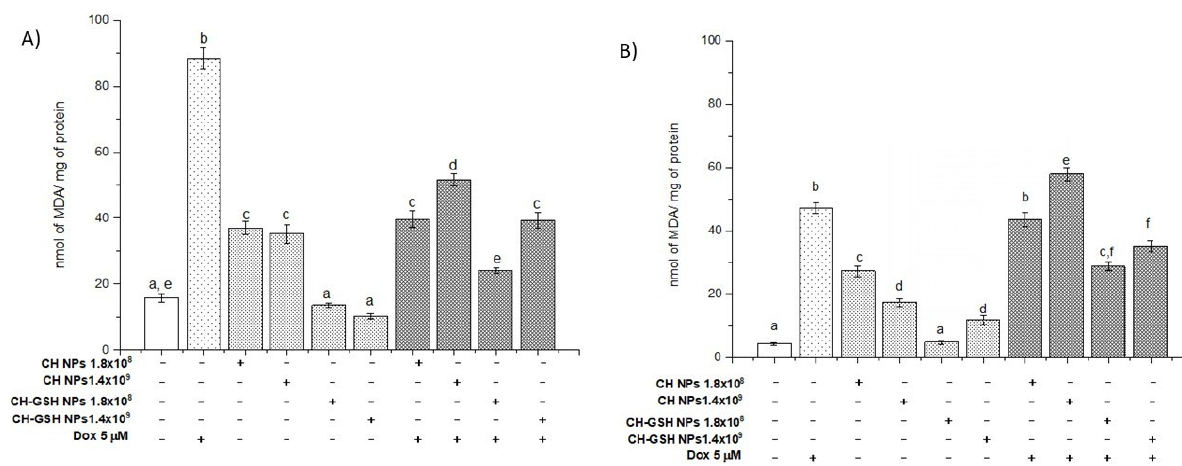
Figure 5. MDA levels of cells exposed to Dox for 12 h and then 2 h with CH-GSH NPs or CH-NPs. MB-231 cells. Bars with equal letters indicate no significant differences between the means (Tukey’s test, p < A) MCF-7 and B) MDA MB-231 cells. Bars with equal letters indicate no significant differences be- tween the means (Tukey’s test, p <0.05).